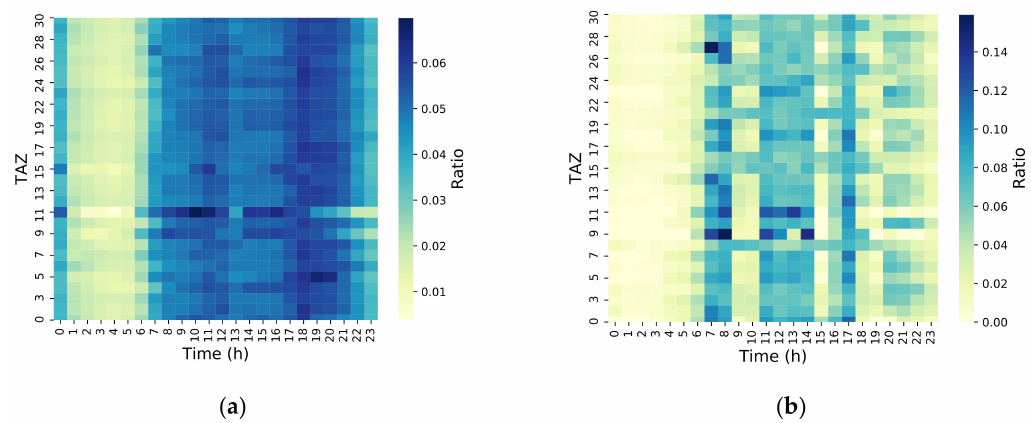
Figure 5. Hourly stay population distribution for TAZ levels. ( a ) CS hourly stay population distribution; ( b ) LPR hourly stay population distribution.